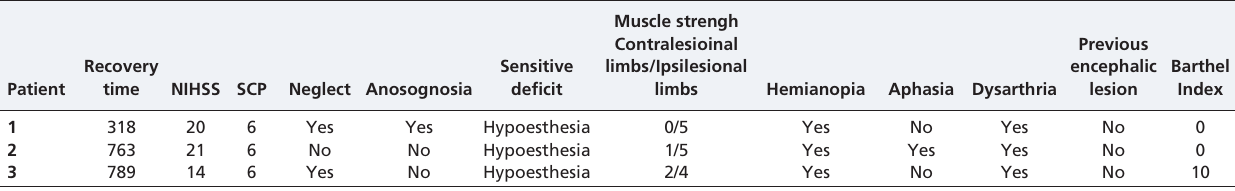
Table 1 - The demographic and clinical data of the